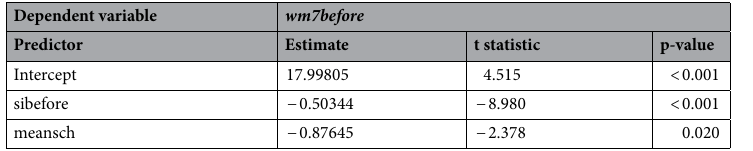
Table 1. Estimation results for a linear model of mobility at the start of the lockdown ( wm7before ) as a function of country characteristics. R 2 : 0.580, Adjusted R 2 : 0.567; F-statistic: 44.85 on 2 and 65 degrees of freedom (n = 68).